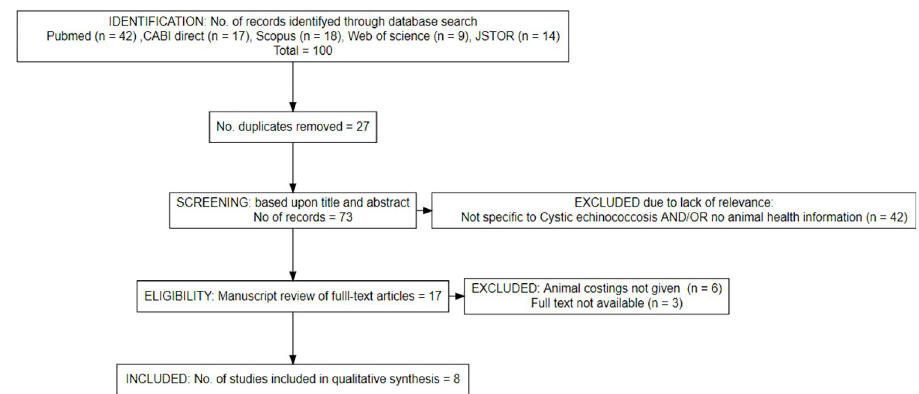
Fig 1. PRISMA flow chart of manuscript selection process for cost of control programmes and interventions against Cystic Echinococcosis in zoonotic reservoirs (definitive and natural intermediate hosts). A total of 100 studies were identified in the initial database search. Duplicates were removed and studies were assessed against the inclusion criteria, resulting in 17 articles being eligible for full manuscript review (six were excluded as no costings for animal health control were given). Eight manuscripts fulfilled the inclusion criteria and were selected for further analysis.